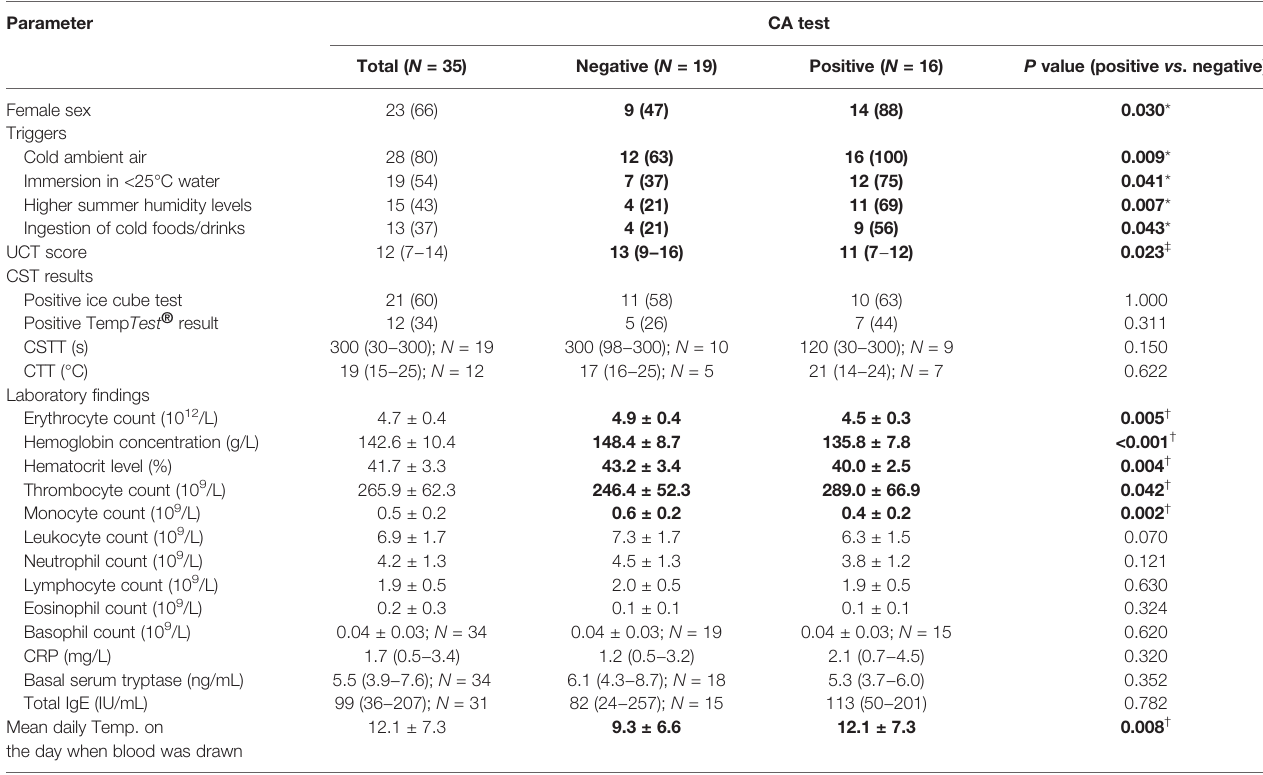
TABLE 2 | Characteristics of patients with a positive vs . negative cold agglutinin